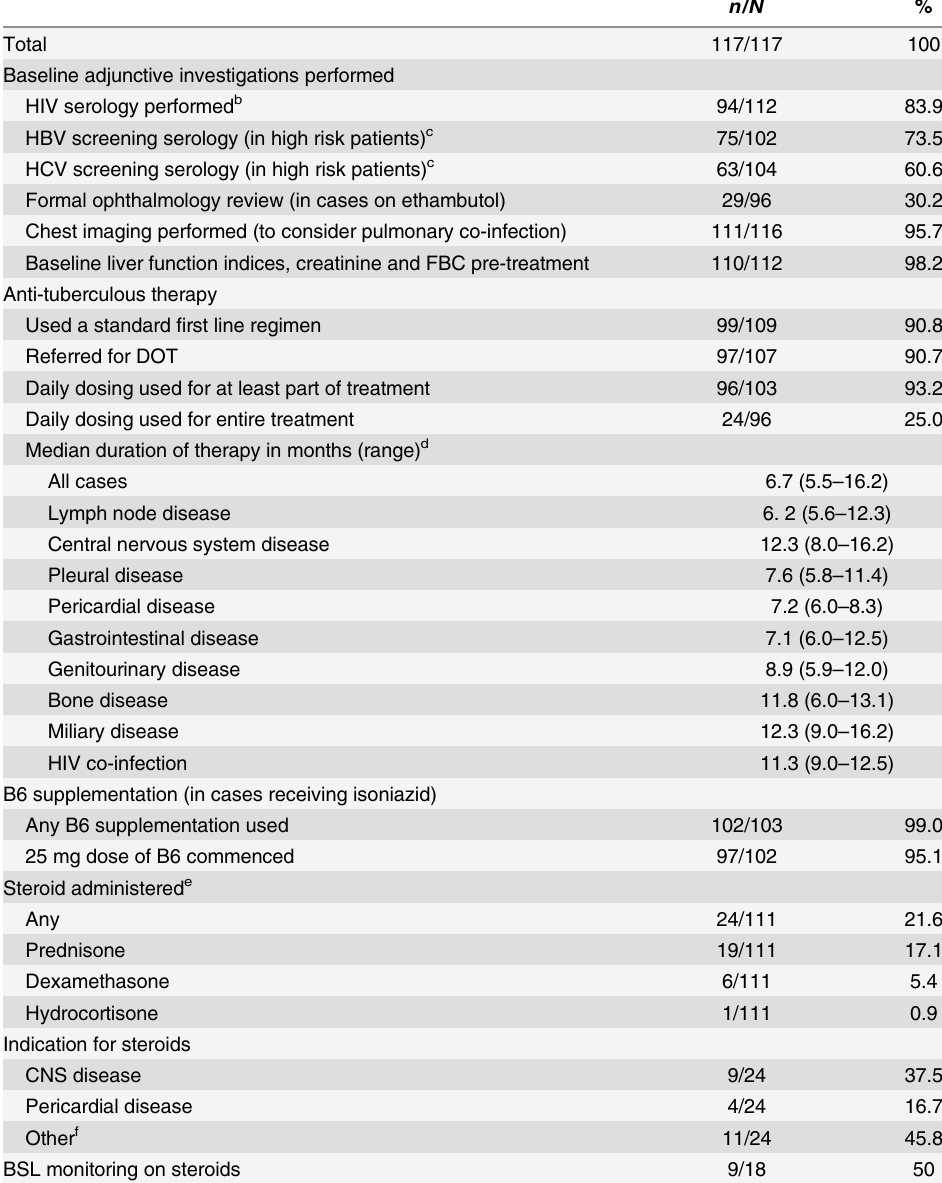
Table 3. Characterisation of clinician management practices.